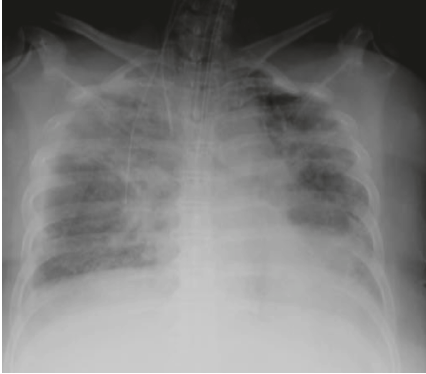
Figure 1: X-ray before transplant.